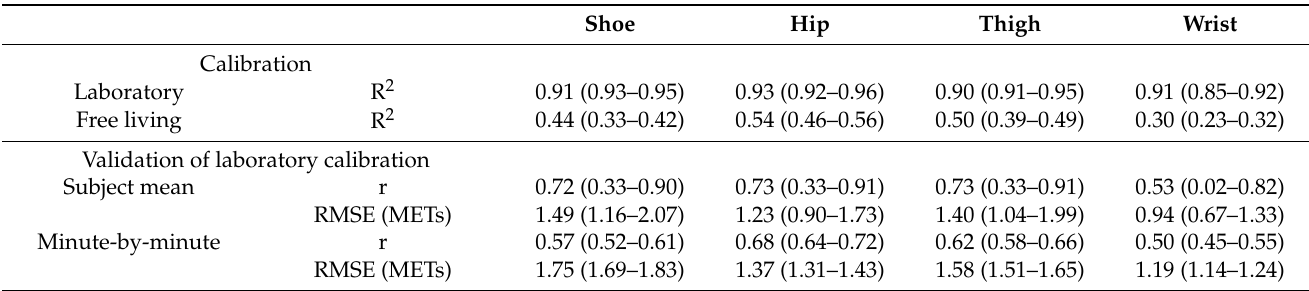
Table 2. Performance of calibration models in laboratory and free living (95%